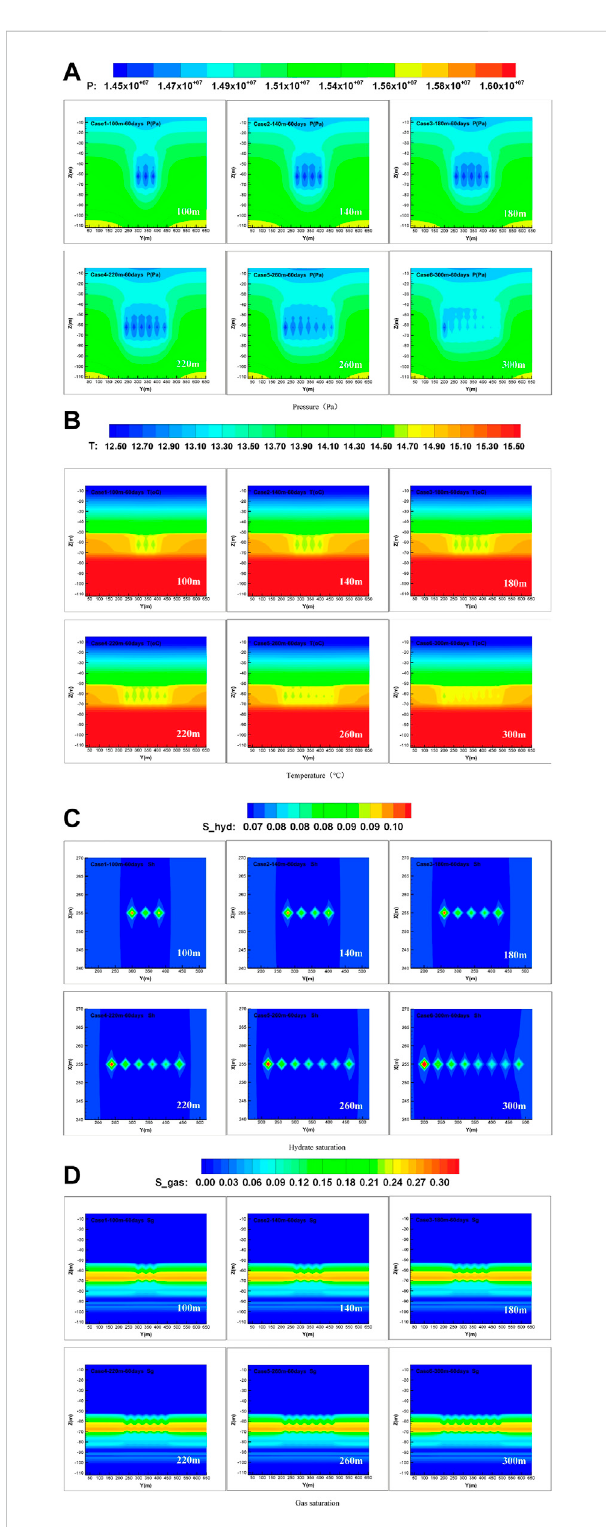
FIGURE 8 Spatial distribution of pressure (A) , temperature (B) ,